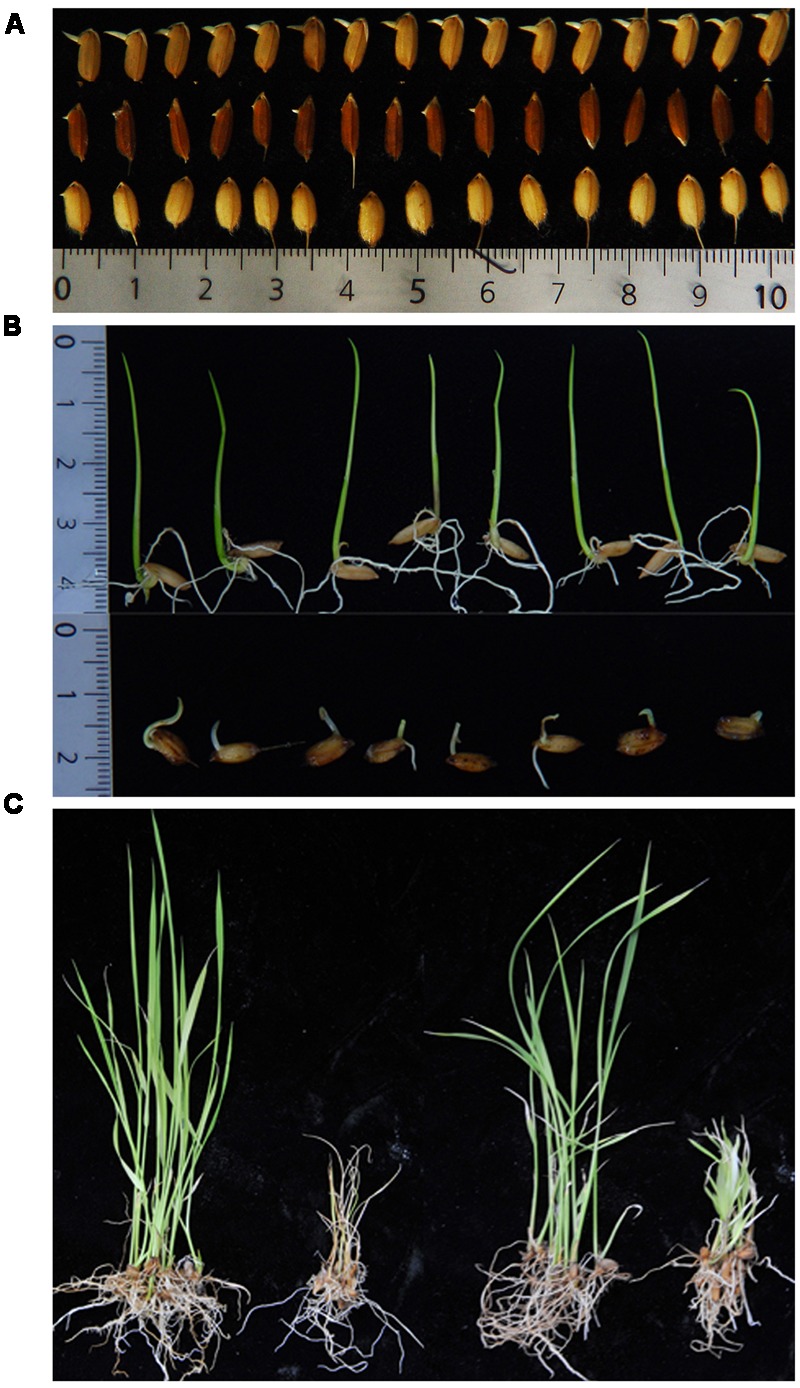
Examples of the five chilling tolerance indices assessed in this study. (A) Low Temperature Germinability (LTG) measures the percent germination of seeds after 30 days of incubation at 10 ± 1°C. First row, ∼100% LTG; second row, ∼50% LTG; third row, ∼10% LTG. (B) Plumule Growth after Cold Germination (PGCG) measures the growth rate of young seedlings at 28 ± 1°C after 30 days of germination at 10 ± 1°C. The first row illustrates high PGCG and the second row low PGCG. (C) Low Temperature Seedling Survivability (LTSS, left two plants), measures the survivability of 2-week-old seedlings after 1 week of incubation at 10 ± 1°C and 1 week of recovery growth at 28 ± 1°C. ∼100% LTSS (far left) vs. ∼0% LTSS (second from left). Plumule Growth after Cold (PGC, right two plants) measures the ability to resume growth at 28 ± 1°C after 1 week of incubation at 10 ± 1°C. ∼100% PGC (2-fold increase; second from right) vs ∼0% PGC (green but no growth; far right).